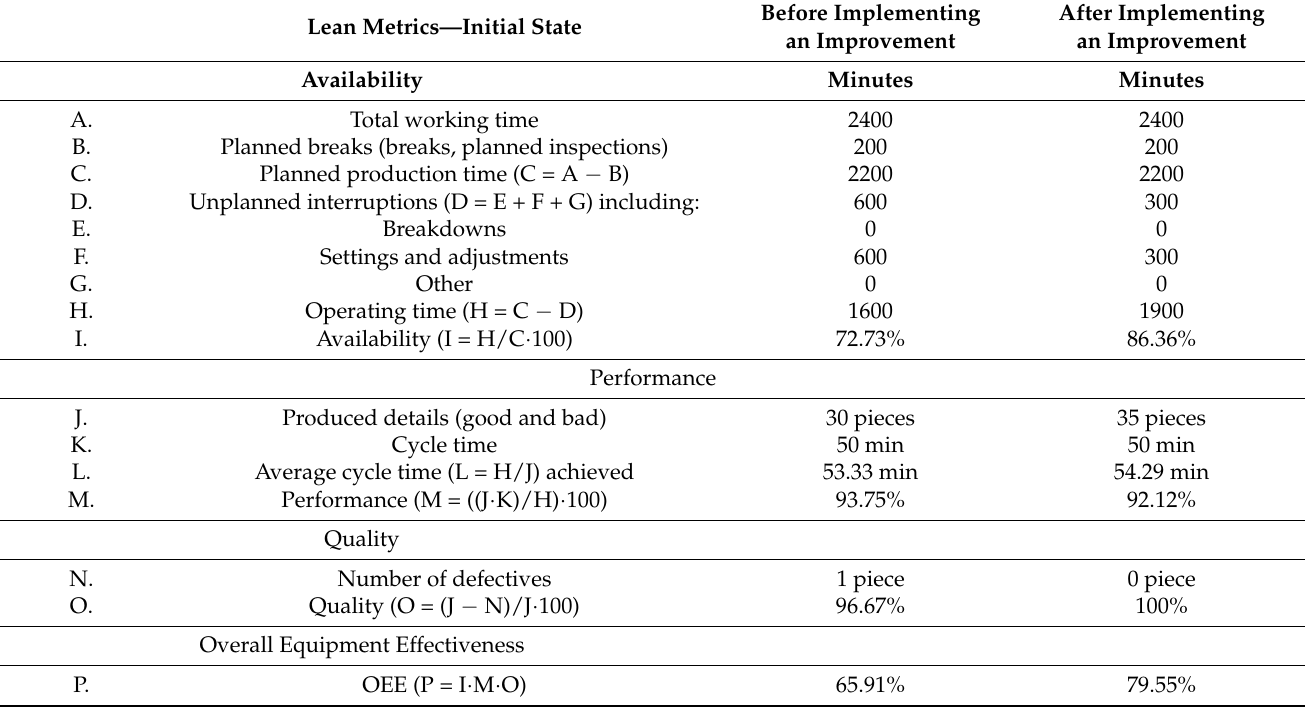
Table 6. Overall Equipment Effectiveness